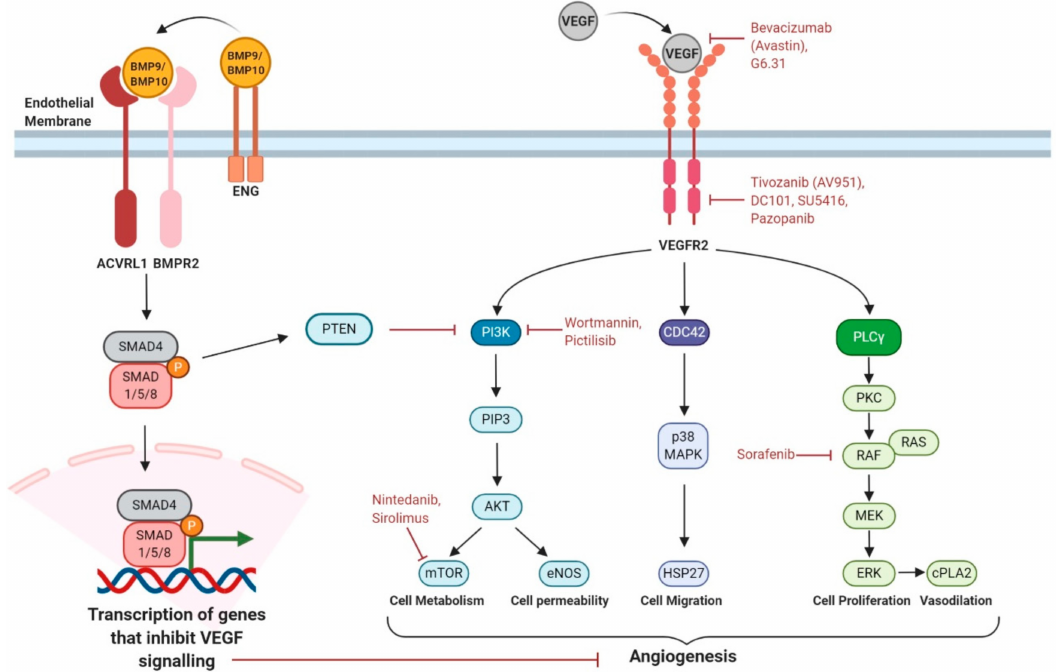
Figure 2. Schematic summary of crosstalk between BMP9/10 and VEGF signalling pathways in endothelial cells. Figure created with BioRender